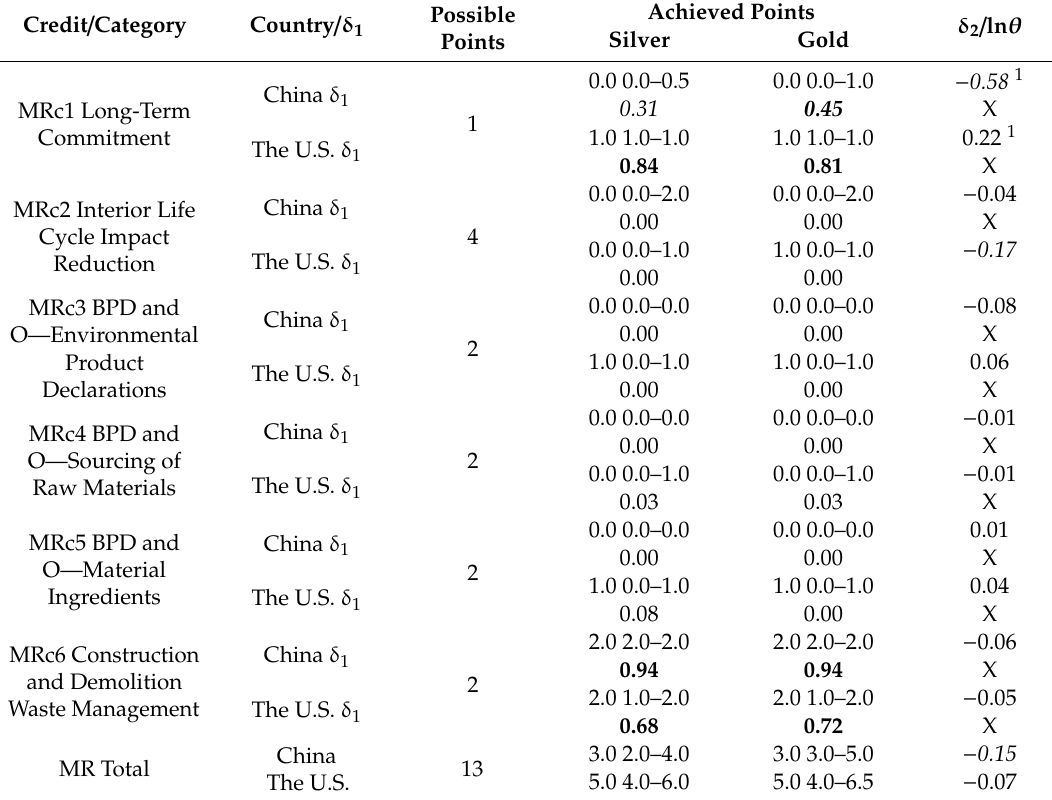
Table 8. LEED-CIv4 Materials and Resources (MR) credits category: The median and 25th–75th centiles and Cli ff ’s e ff ect size ( δ 1 ) of the di ff erence between the achieved and the possible points, and ( δ 2 ) or ln θ of the di ff erence between Silver and Gold projects in China and the